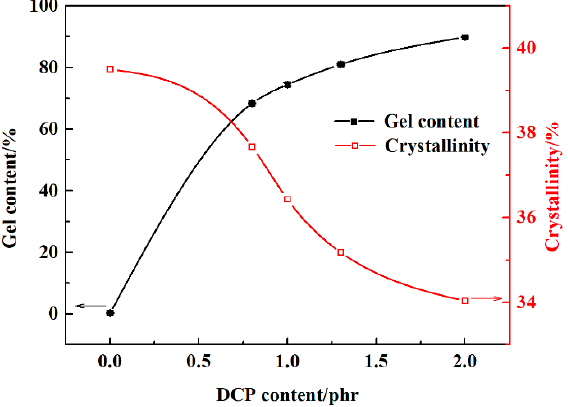
Figure 6. DCP content dependence of gel content and crystallinity for samples.